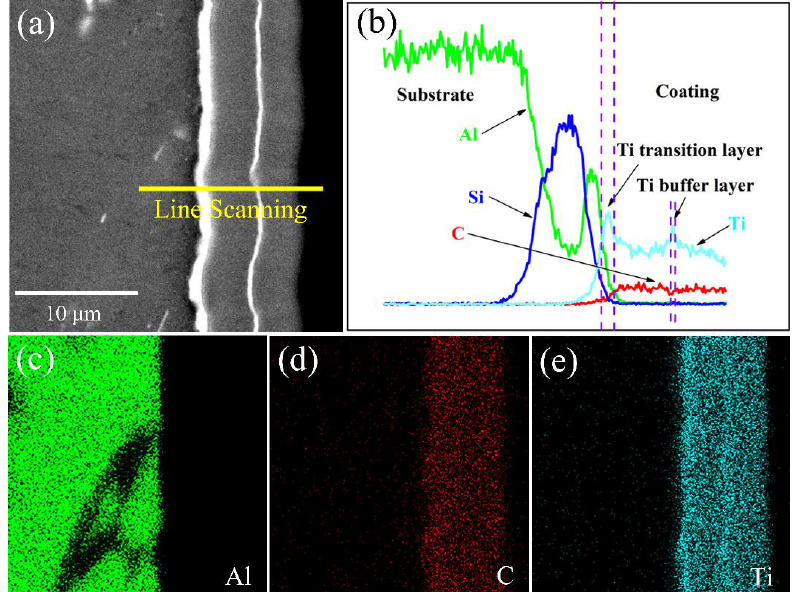
Figure 3. SEM cross-sectional image and EDS results of Ti-DLC coating with Ti transition layer thickness ( t 0 ) 1.1 μm: ( a ) SEM image, ( b ) EDS line scanning, and ( c – e ) EDS maps.